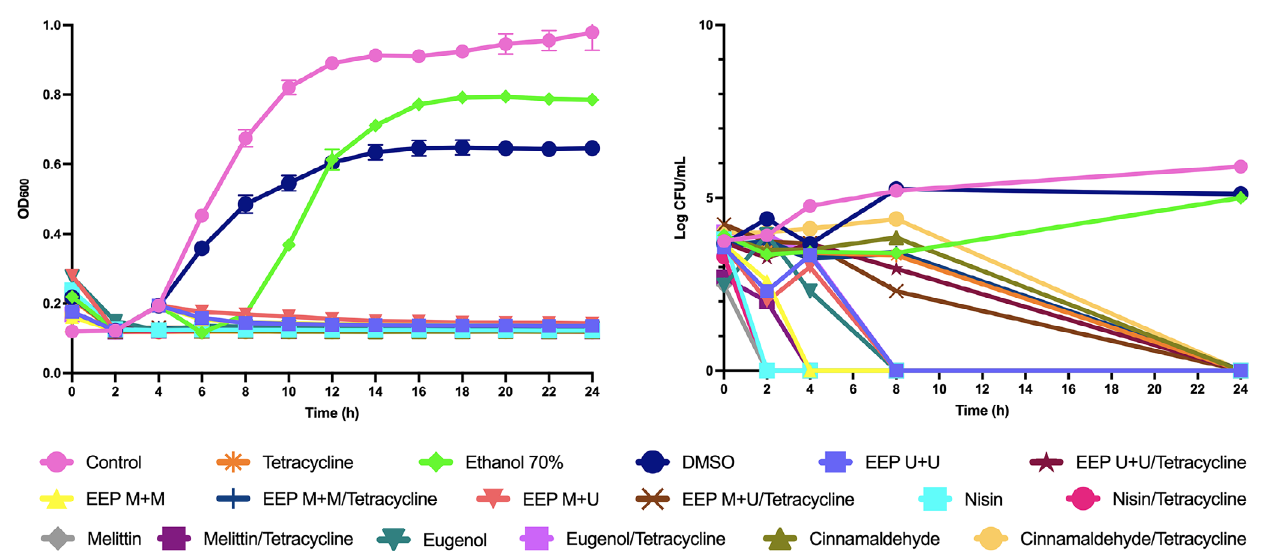
Figure 1. Time-kill curves from OD600 and Log of CFU/mL assays for EEPs, antimicrobial peptides, and major compounds and tetracycline tested alone and in combination with tetracycline on B. subtilis .